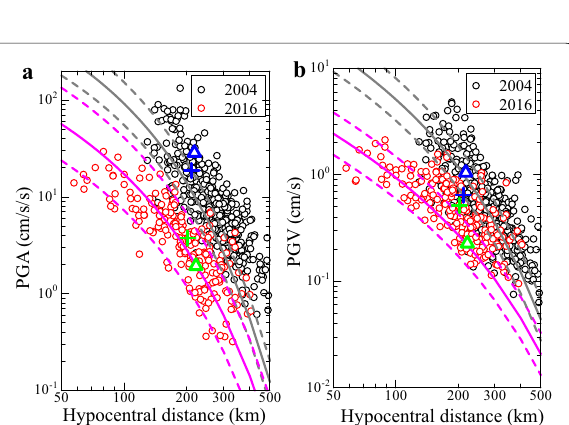
Fig. 9 Comparison of peak ground accelerations (PGAs), a , and peak ground velocities (PGVs), b , observed for the 2004 (black circles) and 2016 (red circles) events. The blue and green crosses denote the values at site AIC004 for the 2004 and 2016 events, respectively. Similarly, the blue and green triangles denote the values at site AICH15 for the two events. The gray and pink solid lines denote the median predictions using the GMPEs (Morikawa and Fujiwara 2013) for the 2004 and 2016 events, respectively. The dashed gray and pink lines show a range of one standard deviation for the corresponding events. The observed values were adjusted for site amplification effects for both events, and the anomalous path effect due to the subducting Philippine Sea Plate for the 2004 event. Note that the correction for the anomalous path effect due to the subducting plate is required only for recordings from events located inside the